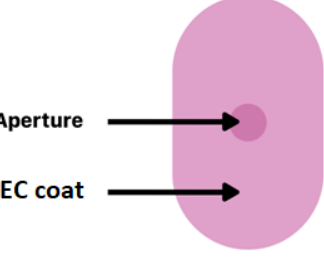
Figure 5. Schematic illustration of DiffCORE ™ system. Reprinted with permission from Reference [16]. Copyright 2019 MDPI.